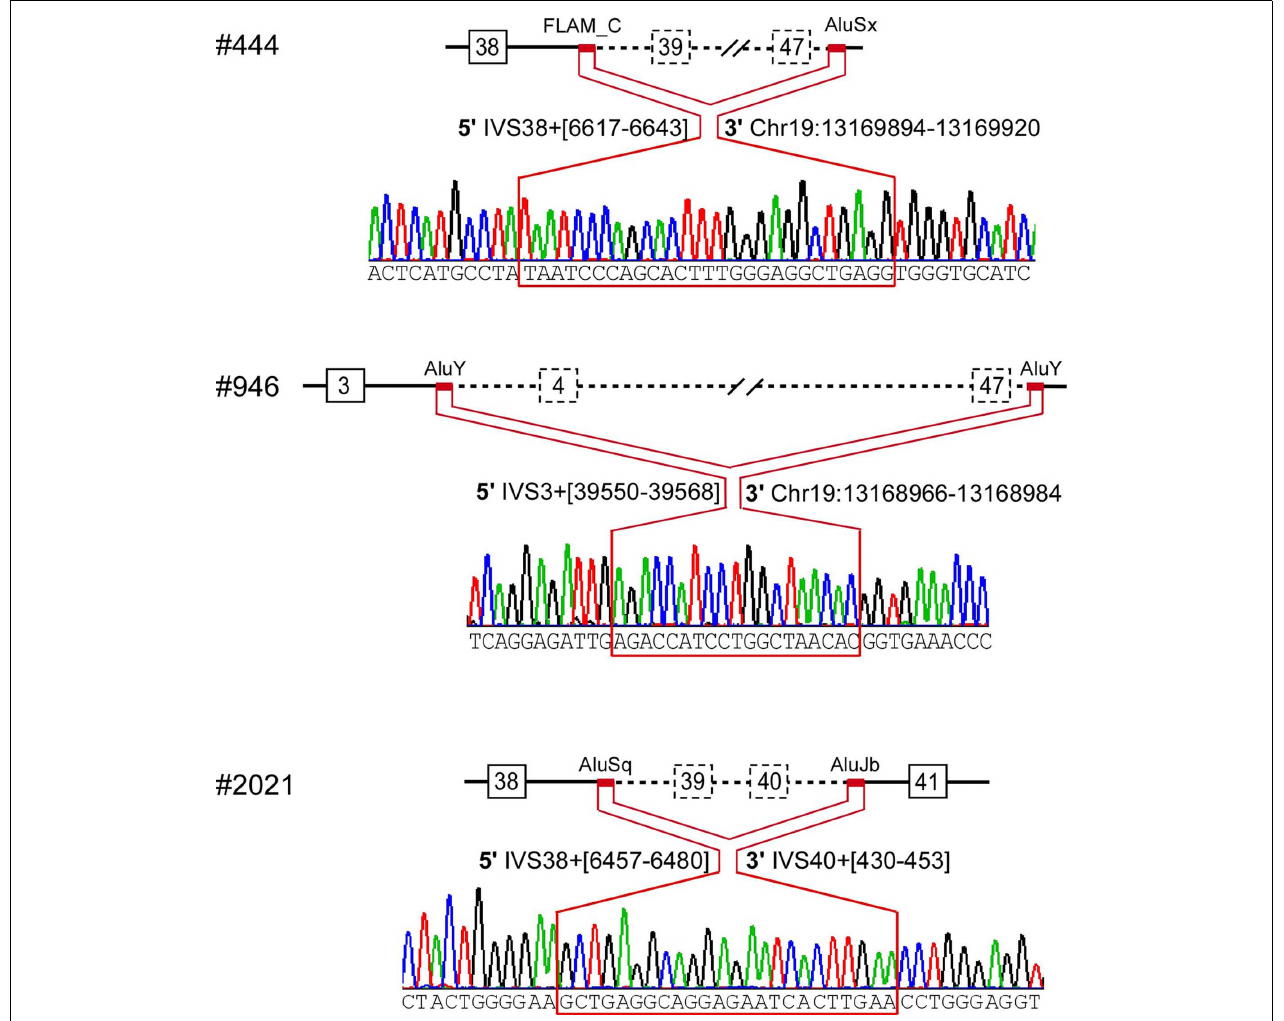
FIGURE 3 | Breakpoint ascertainment. The red lines highlight the stretch of identical sequence shared by the 5 (cid:2) and 3 (cid:2) Alu elements that mediated homologous recombination, with specific nucleotide positions for the 5 (cid:2) and